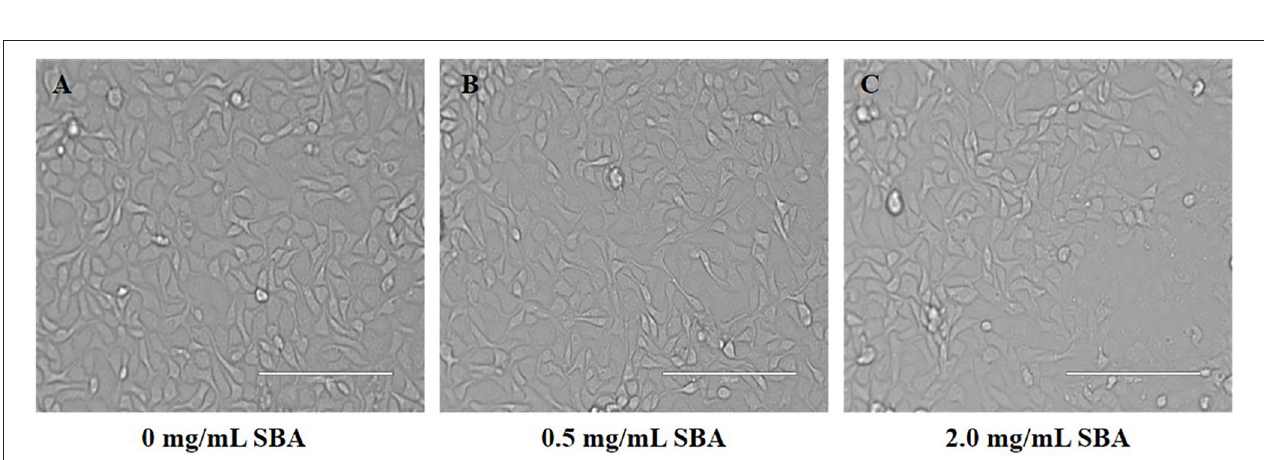
FIGURE 3 | Activation of Casp-3 and Casp-9 by SBA. IPEC-J2 cells were treated with 0.0, 0.5, or 2.0 mg/mL SBA for 24h. The cells in different treatments were collected and the activities of the Casp-3 (A) and Casp-9 (B) were determined using ELISA. Data are represented as means ± standard error of the mean (SEM) from three independent experiments, relative to control. Different lowercase letters (a, b, c) represent significant differences among groups ( p < 0.05).